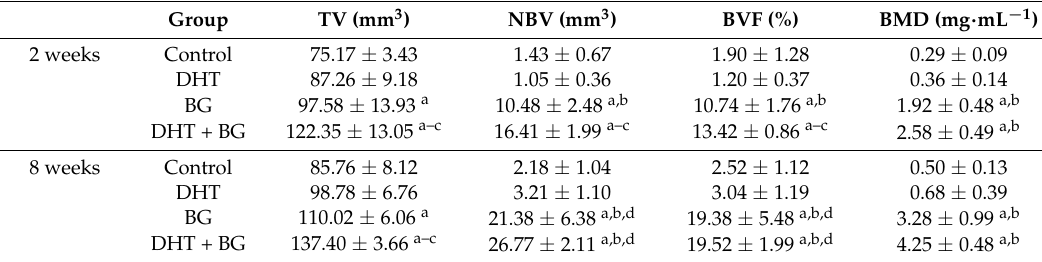
Table 1. Micro-CT measurements of the rat calvarial defect at 2 and 8 weeks after surgery.